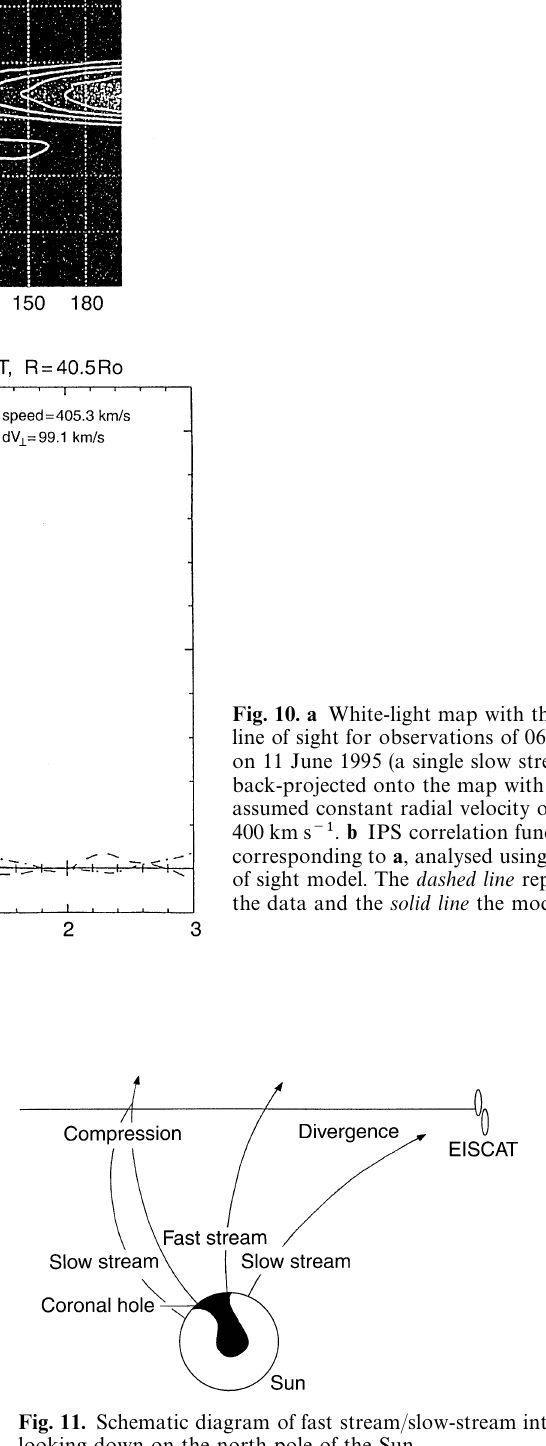
Fig. 11. Schematic diagram of fast stream/slow-stream interaction, looking down on the north pole of the Sun region of open flux underneath a region of outward-flow- ing slow wind (Fig. 11). Under these circumstances the fast stream will overtake the slow stream at one boundary, and diverge from it at the